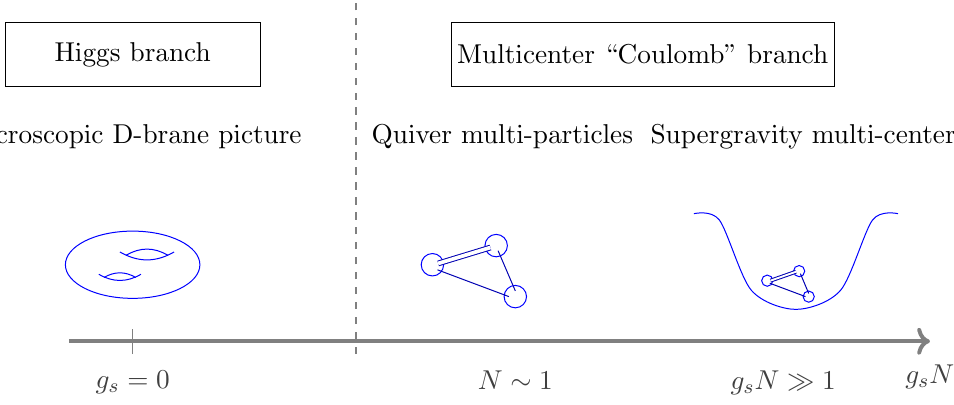
Figure 1 . The description of a D-brane system in di(cid:11)erent regimes of parameters where g s is the string coupling and N is the total number of